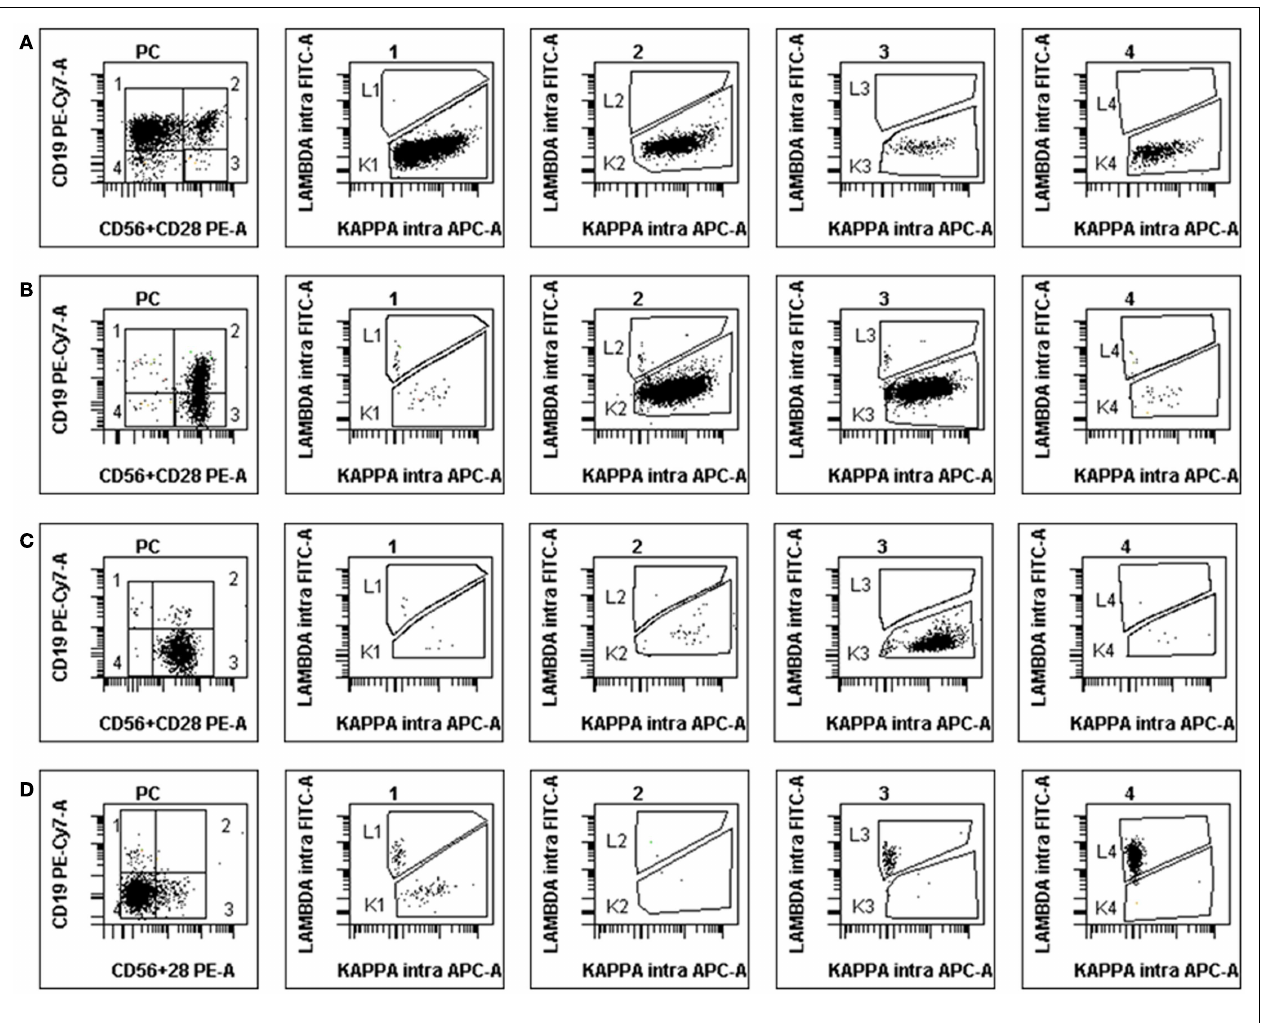
FIGURE 3 | Examples of abnormal PCs in MM BM samples at diagnosis .The disposition is the same as in Figure 2 , light-chain expression being shown in the four subsets (1–4). (A) Patient with κ -restricted abnormal PC presents mostly in subgroups 1 and 2 but also 3 and 4. (B) Patient with κ -restricted abnormal PC presents mostly in subgroups 2 and 3, with polyclonal residual normal PC in subgroup 1.